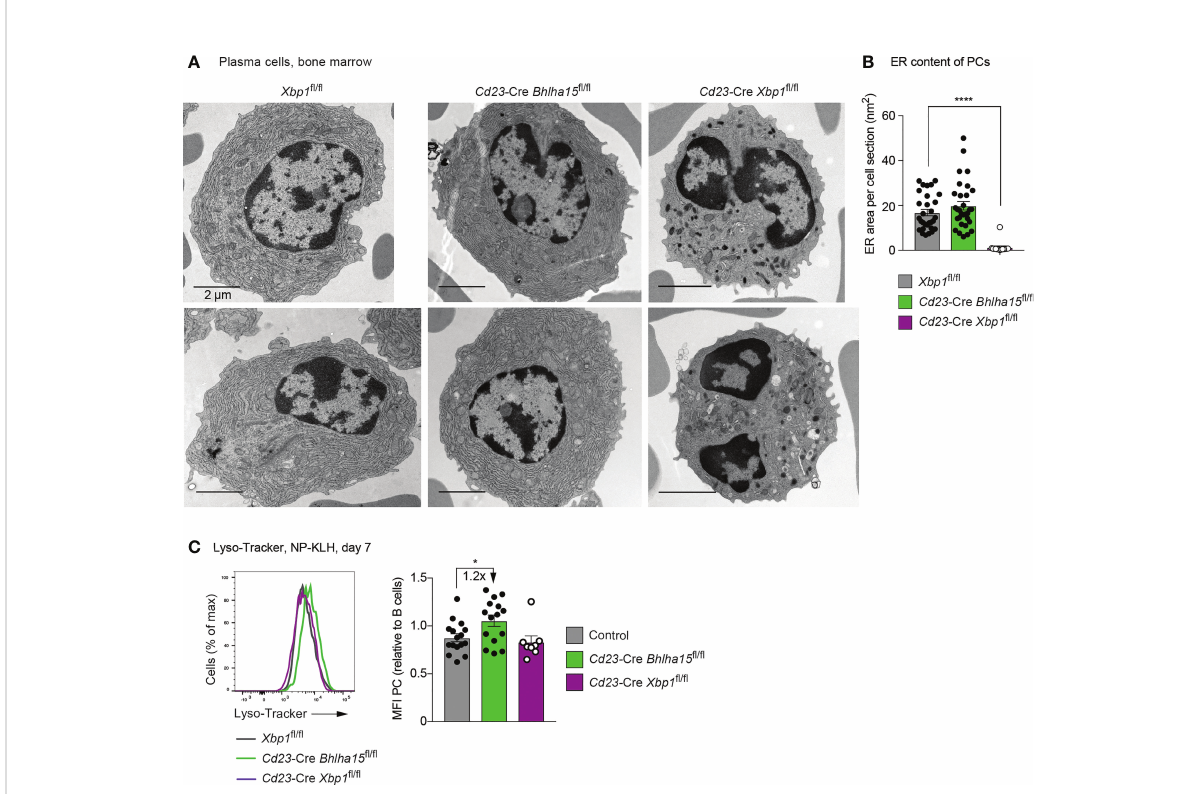
FIGURE 4 Normal morphological structure of Cd23 -Cre Bhlha15 fl / fl plasma cells. (A) Electron microscopic analysis of bone marrow PCs of the indicated genotypes, which were sorted as B220 int CD28 + CD138 + Lin – cells, fi xed and processed as described in Methods. The scale bars indicate 2 µm. The cells surrounding the PCs are erythrocytes. (B) Quanti fi cation of the content of endoplasmic reticulum (ER) in PCs of the different genotypes. The ER content was manually determined by using the Fiji software. Each dot represents one PC. In total, 33 Xbp1 fl / fl PCs, 14 Cd23 - Cre Xbp1 fl / fl PCs, and 31 Cd23 -Cre Bhlha15 fl / fl PCs were analyzed. (C) Staining of splenic PCs (TACI + CD138 + ) of the indicated genotypes with Lyso-Tracker at day 7 after NP-KLH immunization (left). The MFI values of the Lyso-Tracker staining (right) are shown for all PCs analyzed in 3 independent experiments. Each dot represents one mouse. Statistical data (B, C) are shown as mean values with SEM and were analyzed with the unpaired Student ’ s t test; * P < 0.05; **** P <